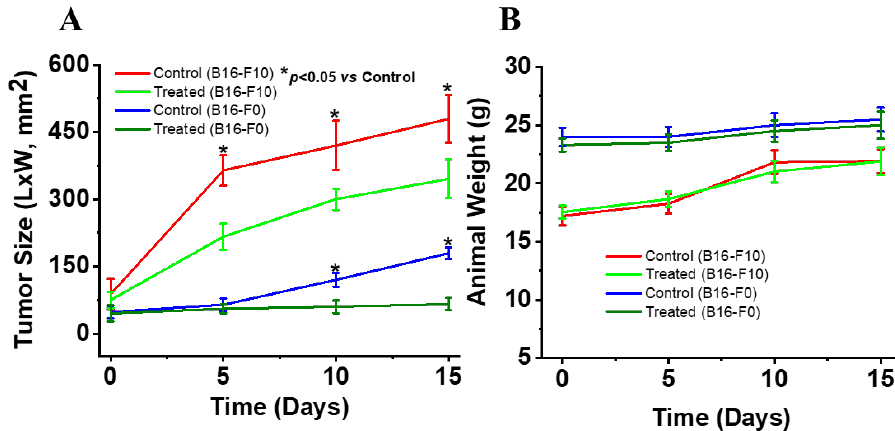
Figure 8. Anticancer effect and body weight changes with topical 2HF in mouse melanoma. ( A ) 2HF in Pluronic Lecithin Organogel (PLO) gel (12 mg/0.1 mL) was applied to the surface of B16-F0 melanoma subcutaneous syngeneic tumors and 20 mg/0.1 mL on B16-F10 melanoma (intradermal implant) C57BL6 mice ( n = 8 per group). Treatment began on day 0 (10 days after subcutaneous/intradermal injection of 1 × 10 6 cells/0.1 mL PBS), at which time all mice had palpable melanoma nodules ~ 8 × 8 mm in size. Bi-dimensional measurements were made using calipers and the product of these measurements was plotted vs. time (days). ( B ) The animal weights (g) as measured during the experiment are shown.